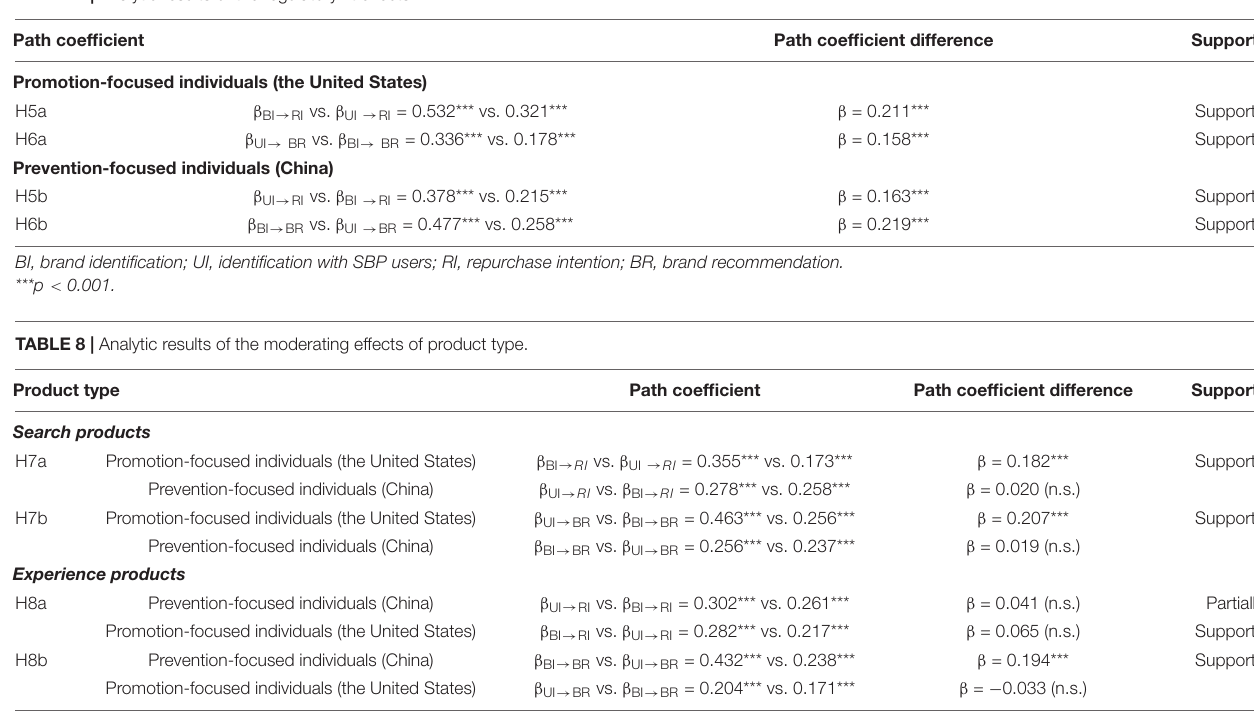
TABLE 7 | Analytic results of the regulatory fit effects.